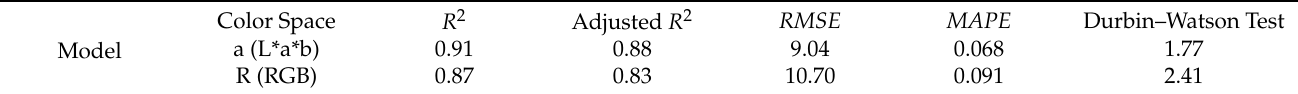
Table 1. Comparison of the prediction results of “a” parameter and “R”